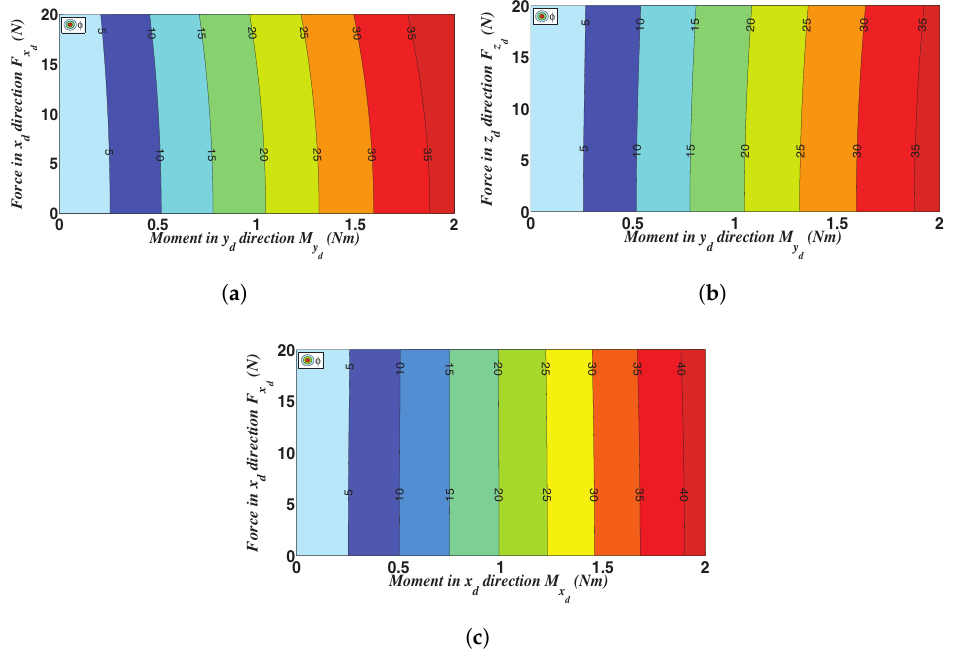
Figure 9. Contour plots of φ for three extreme loading cases: ( a ) moment M y M y and force for F z d